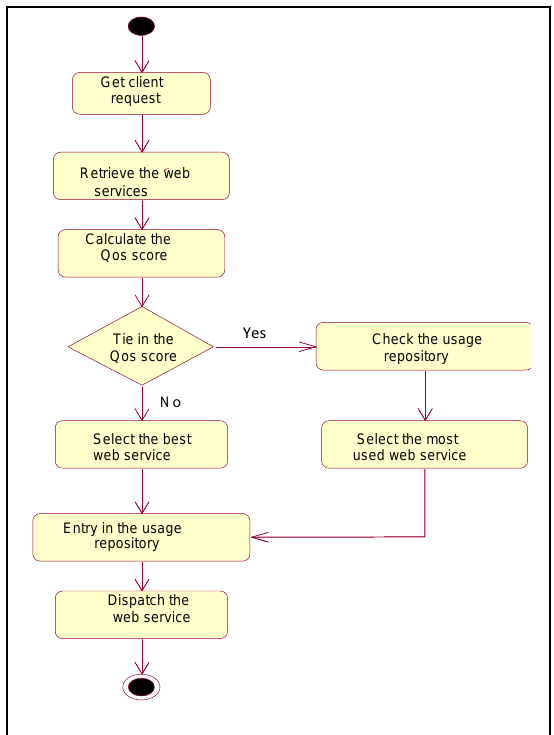
Figure 5 . Flow chart for QoS